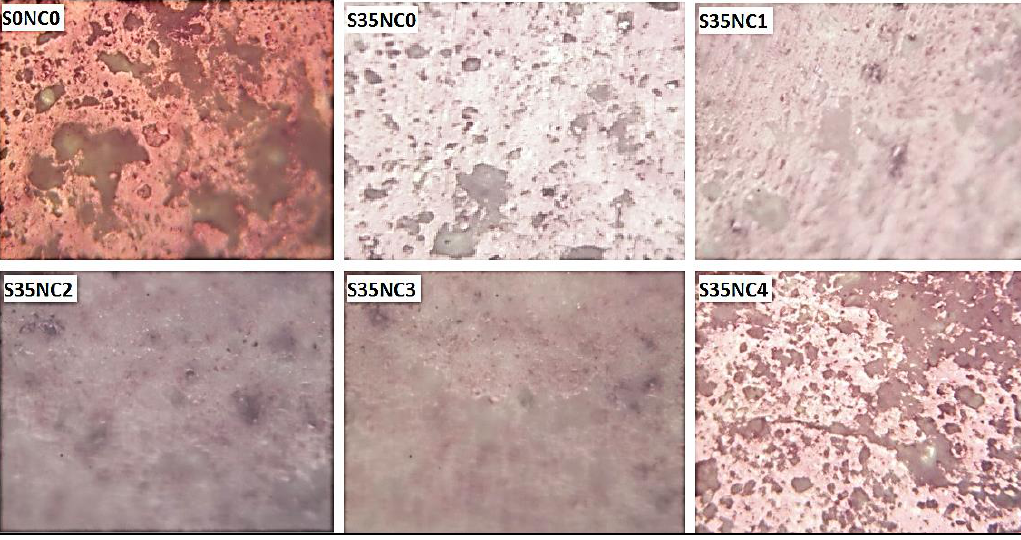
Figure 7. The optical microscopy images of the cement specimens exposed to 300 °C.